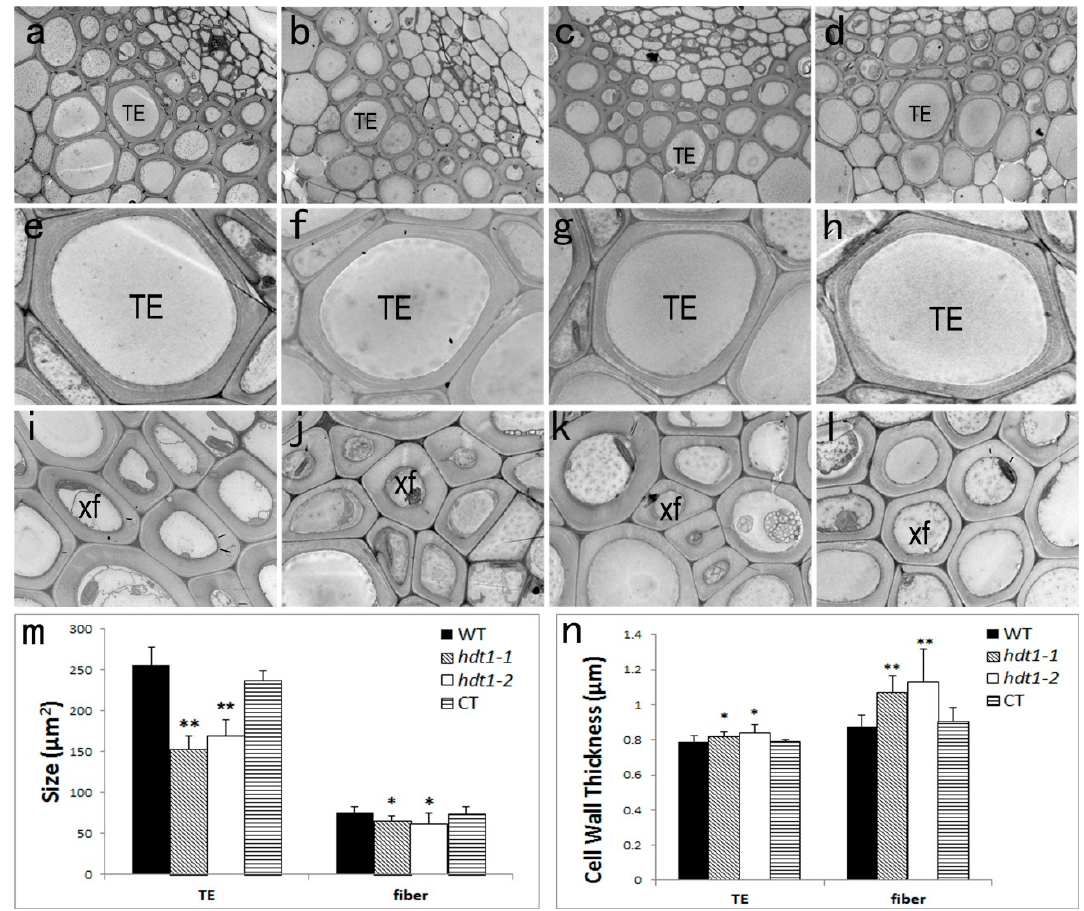
Figure 2. TEM of fiber cells and tracheary elements of the hdt1 mutant, the CT line, and wild-type plants. Fiber cells and tracheary elements from the T3 stage were sectioned and examined under TEM. ( a ), ( b ), and ( i ) Xylem cells in wild-type plants. ( a ) Overview of xylem cells. High-magnification images of tracheary elements ( e ) and fiber cells ( i ) in wild-type plants are shown. ( b ), ( f ), and ( j ) Xylem cells in hdt1-1 plants. ( b ) Overview of xylem cells. High-magnification images of tracheary elements ( f ) and fiber cells ( j ) in hdt1-1 plants are shown. ( c ), ( g ), and ( k ) Xylem cells in hdt1-2 plants. ( c ) Overview of xylem cells. High-magnification images of tracheary elements ( g ) and fiber cells ( k ) in hdt1-2 plants are shown. ( d ), ( h ), and ( l ) Xylem cells in the CT lines. ( d ) Overview of xylem cells. High-magnification images of tracheary elements ( h ) and fiber cells ( l ) in the CT lines are shown. ( m ) Sizes of tracheary elements (TEs) and fiber cells were measured in wild-type, hdt1-1 , hdt1-2 , and CT lines. ( n ) The cell wall thickness of tracheary elements and fiber cells is shown in both wild-type and hdt1 plants. The cell wall thickness was measured as the mean value of several symmetrical points across the cell wall of each cell. Scale bars = 20 μ m ( a – d ) and 5 μ m ( e – l ). The tracheary elements (TEs) and xylary fiber (XF) are indicated. (Data are means of three replicates ± SD. **, p -value < 0.01; *, p -value < 0.05).